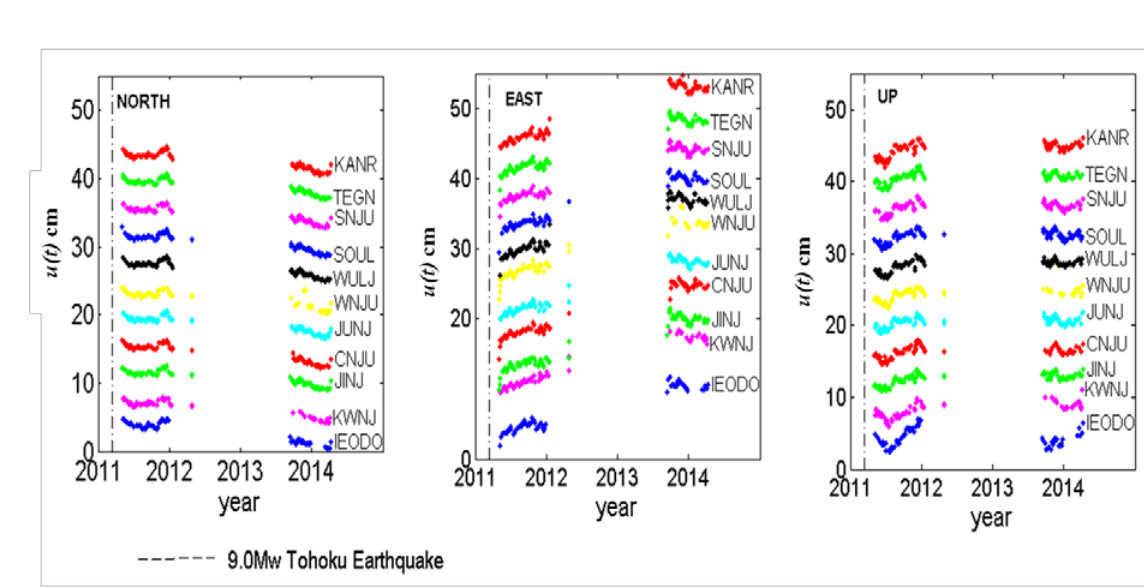
Figure 3: Daily time series of 3-dimensional coordinate of NGII and IEODO stations before removing linear plate motion.